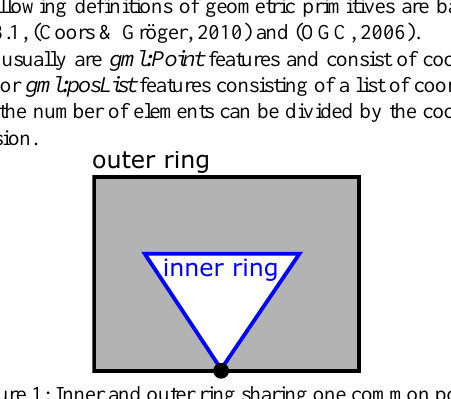
Figure 1: Inner and outer ring sharing one common point.